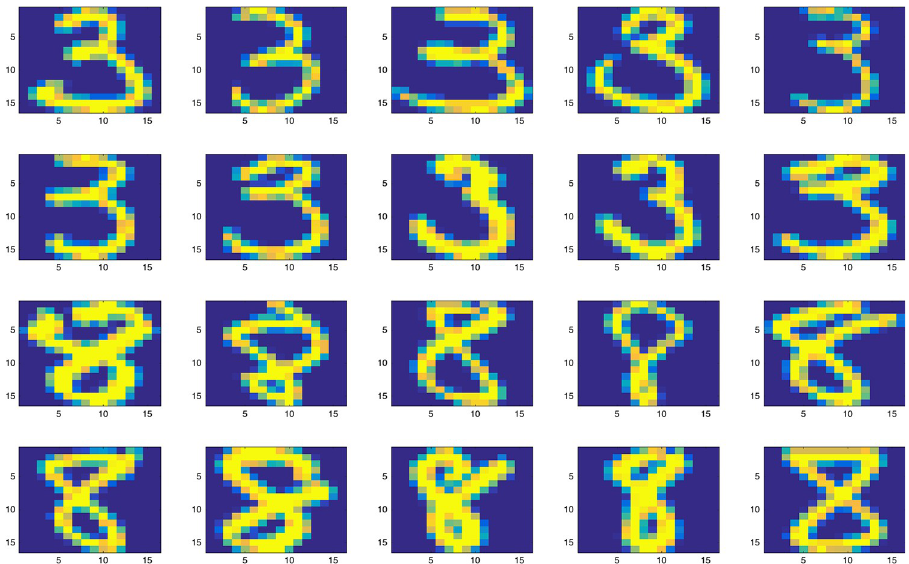
Fig 4. Real data analysis. Some examples of handwritten 3’s and